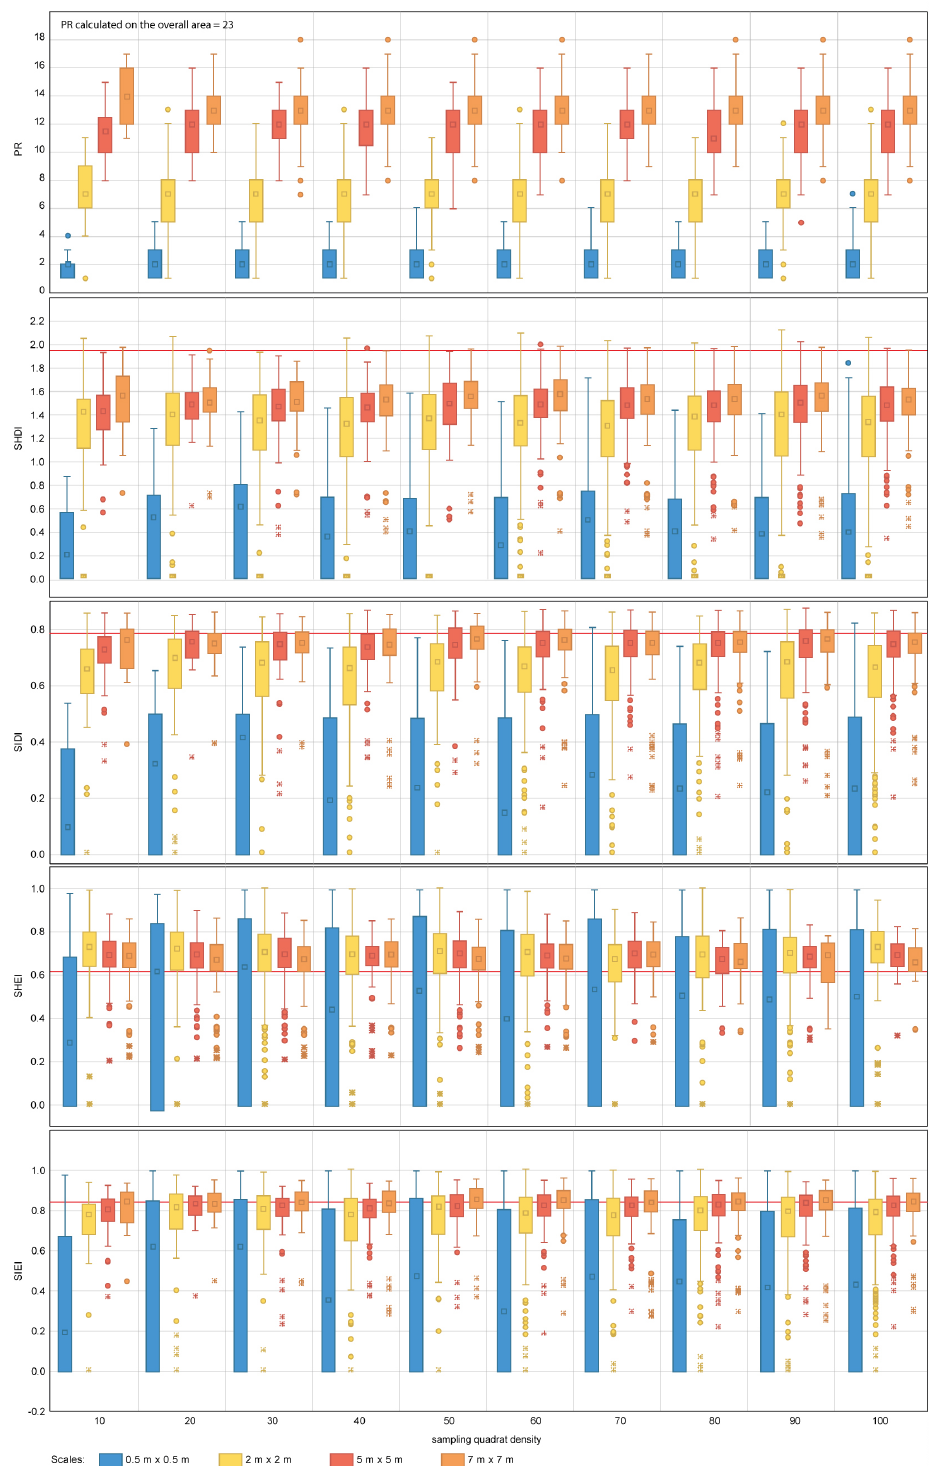
Figure 9. Diversity metric values obtained for the random sampling strategy for the range of scales and quadrat densities considered. The red horizontal line indicates the metric value obtained for the total area mapped. PR, SHDI, SIDI, SHEI and SIEI stand for Patch Richness, Shannon’s Diversity Index, Simpson’s Diversity index, Shannon’s Evenness Index and Simpson’s Evenness Index, respectively. The boxplots show the first, second (median), third and fourth quartiles. Circles and crosses indicate outliers and extreme values,